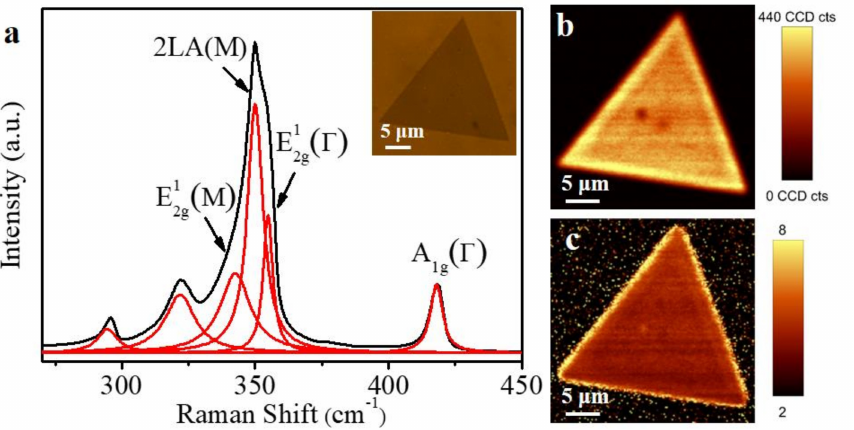
Figure 2. ( a ) Raman characterization of the monolayer WS 2 triangle flake with 532 nm excitation wavelengths. ( b ) A1g( Γ ) intensity mapping for the WS 2 triangle flake. ( c ) Intensity ratio mapping of 2LA(M) over A1g( Γ ) for the WS 2 triangle